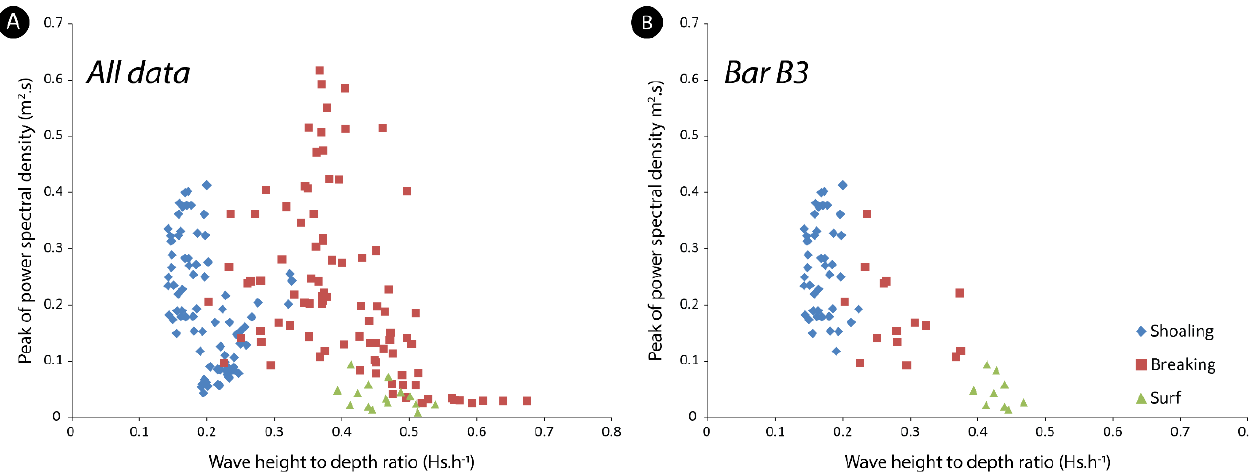
Figure 9. Peak of wave power spectral density during individual burst records plotted as a function of wave height to depth ratio ( H s /h ) for ( A ) data recorded by all instruments across the intertidal zone and ( B ) data recorded on bar B3.